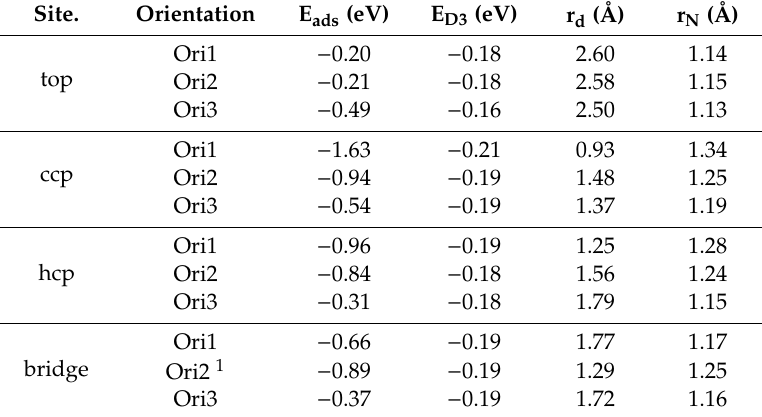
Table 1. Adsorption parameters of N 2 adsorption on PuH 2 (111) surface. The parameter r d is the vertical distance from the surface to the closest N atoms, and r N is the N-N distance in the adsorbed N 2 molecule. E D3 denotes the increase of the adsorption energies with the inclusion of the D3 corrections. Site. Orientation E ads (eV) E D3 (eV) r d (Å) r N (Å) Ori1 − top